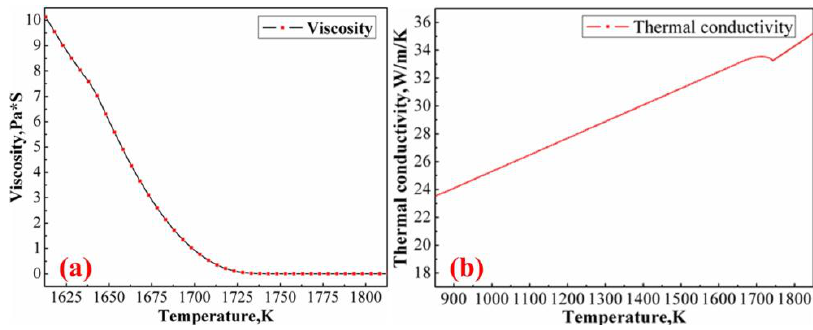
Figure 3. Variations of viscosity ( a ) and thermal conductivity ( b ) with local temperature.